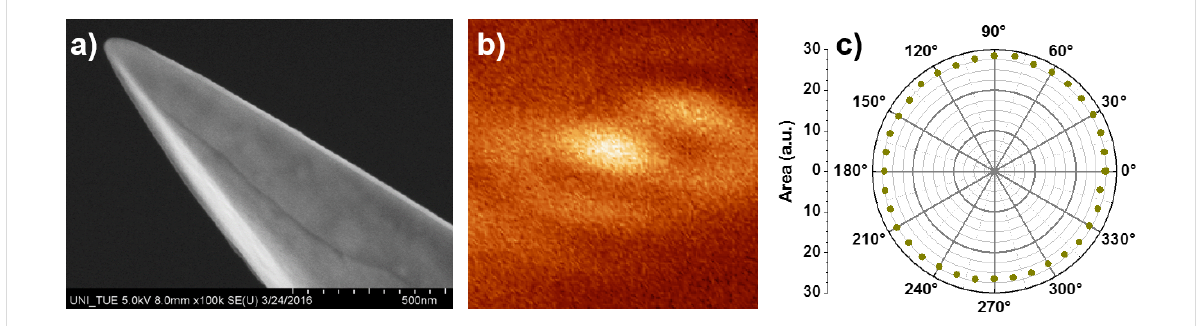
Figure 4: a) SEM image of the tip used. b) Optical image of the tip in focus. c) Polarization angle-resolved luminescence of the tip in focus without a sample; an almost perfectly circular emission pattern is observed.